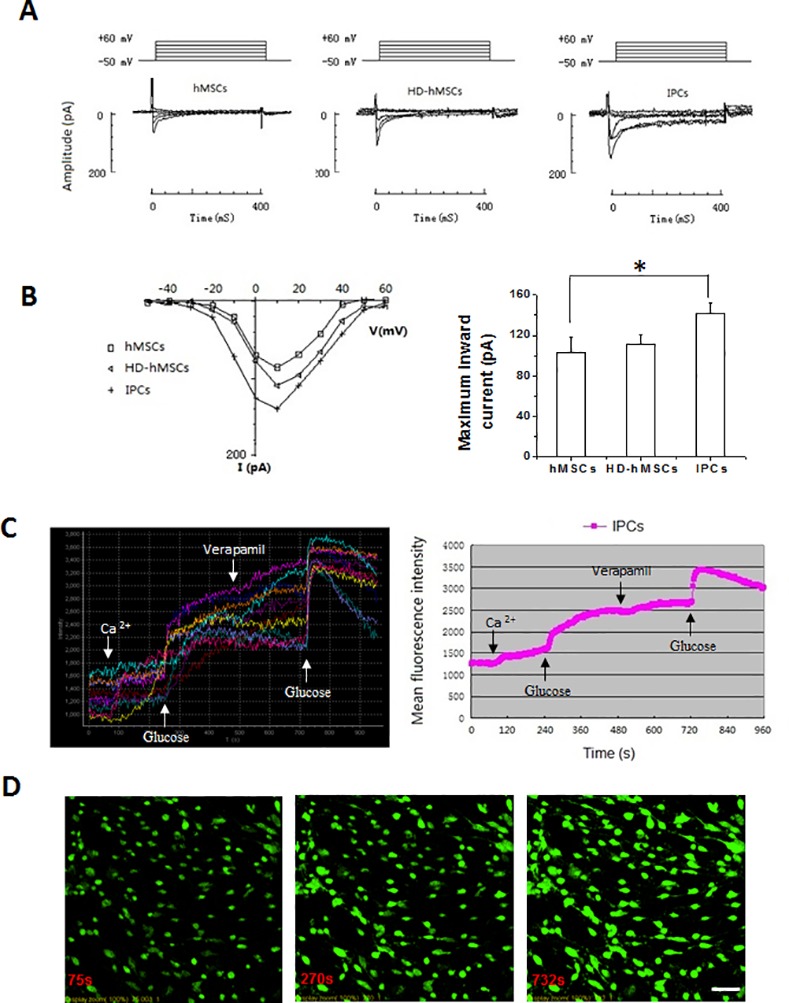
Measurement of L-type Ca2+ channels during differentiation process and intracellular Ca2+ concentration in IPCs in response to glucose stimulation.The whole-cell patch-clamp experiments were performed on hMSCs, HD-MSCs and IPCs to determine the amount and functional change of L-type Ca2+ channel during the differentiation process. Nifedipine at 10 μM suppressed the inward currents. Nifedipine-sensitive inward Ca2+ currents (ICa.L) were recorded by 300-ms voltage step between +10 and +60 mV from a holding potential of –50 mV (to inactivate INa). A: The ICa.L was recorded among the hMSCs, HD-MSCs and IPCs. B: The I-V relationship of ICa.L displayed the maximum current peak appeared at 10 mV in hMSCs, HD-MSCs and IPCs (left), and the mean peak current amplitudes in IPCs is higher than that in hMSCs or HD-MSCs (right, *P<0.05 compared to hMSCs). C: The changes of intracellular Ca2+ concentration in IPCs in response to glucose stimulation were measured by labeling with Fluo-3/AM under laser confocal scanning microscopy. The results were expressed as respective fluorescence intensity of 10 of IPCs (left) and average fluorescence intensity of 30 of IPCs (right). After stimulated with 30mmol/L glucose at 240 s, the intracellular Ca2+ concentration rapidly increased in IPCs due to significant Ca2+ influx when extracellular Ca2+ existing. When Ca2+ channels were blocked by 25 mg/ml of Verapamil at 480 s and then stimulated with 3.5 mM glucose at 720 s, intracellular Ca2+ rapidly increased again in IPCs due to the release of Ca2+ from calcium stores. D: The images of intracellular Ca2+ before (left) and after 2 times of glucose stimulation (middle and right) in IPCs, reflected by green fluorescence. Scale bars: 50μm for D.